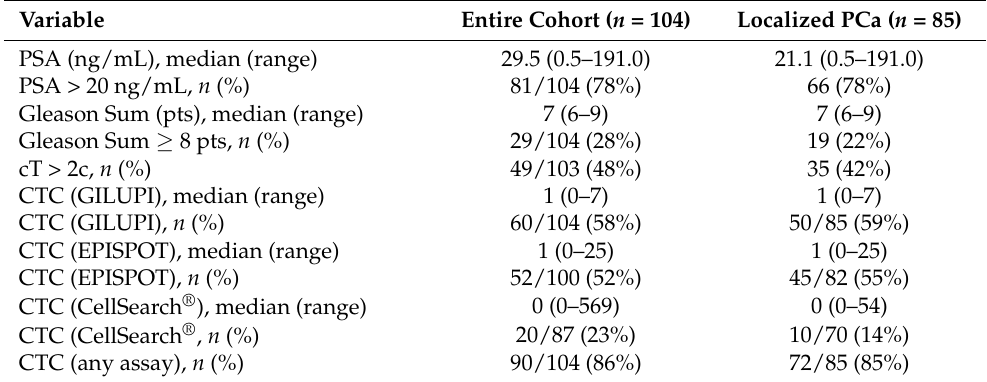
Table 1. Clinical characteristics of the entire group of PCa patients participating in the study ( n = 104) and the group of patients with localized PCa at baseline ( n = 85), in addition to baseline CTC counts detected using the GILUPI CellCollector, EPISPOT assay and CellSearch ® system. Variable Entire Cohort ( n = 104) Localized PCa ( n = 85) PSA (ng/mL), median (range) 29.5